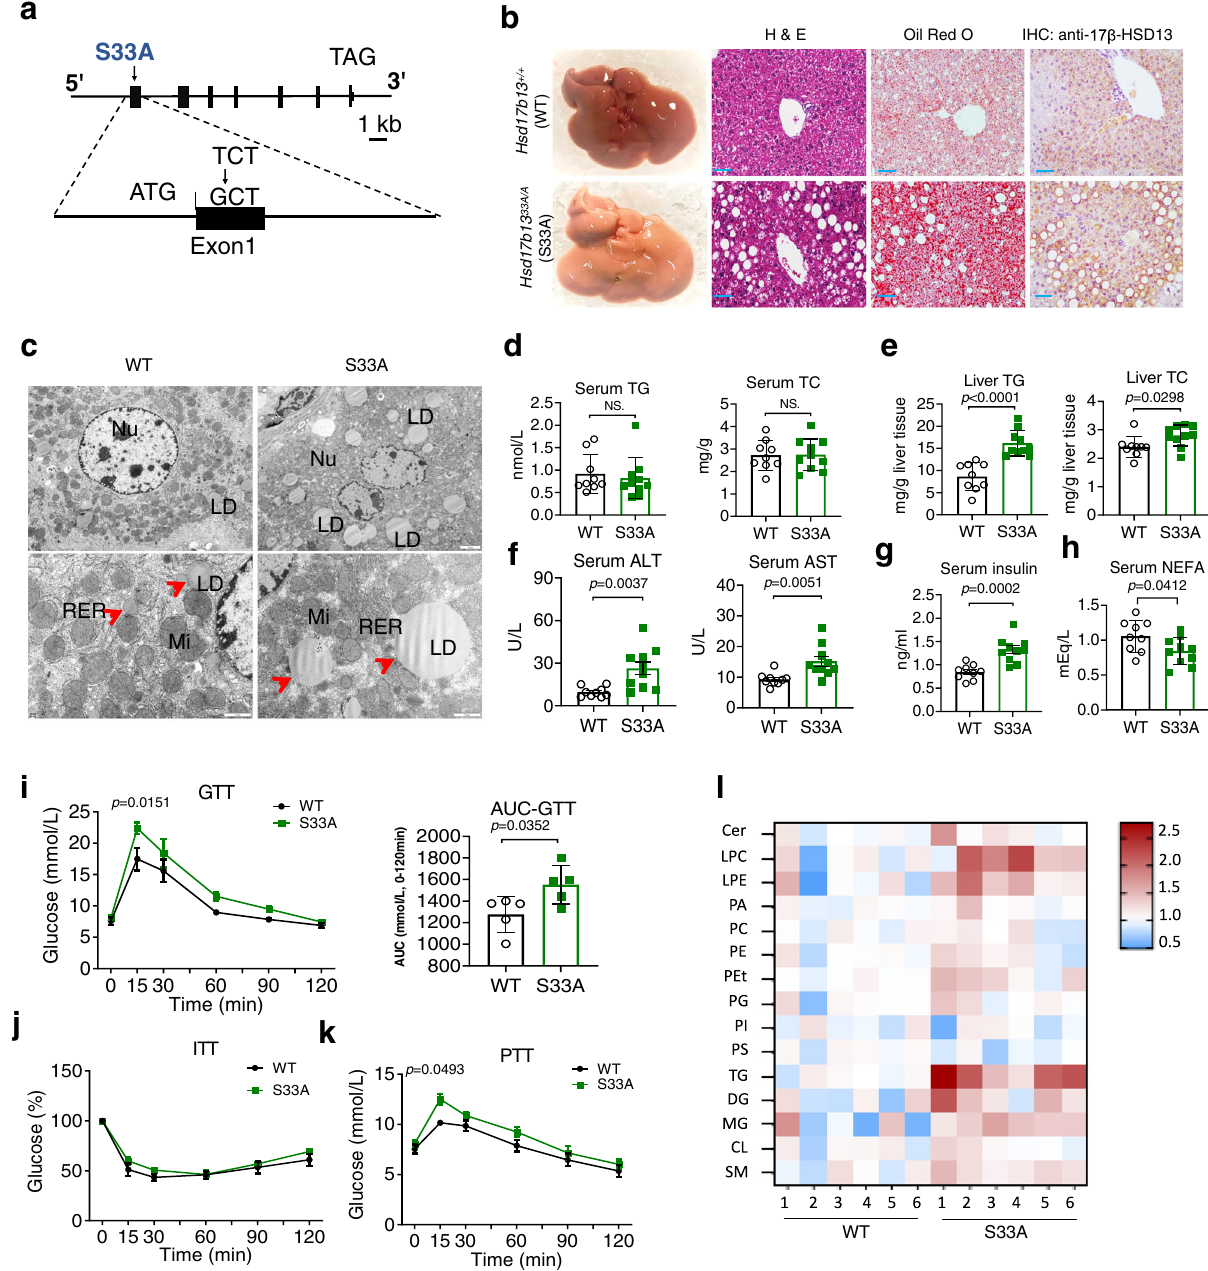
Fig. 3 | Targeted knock-in of the 17 β -HSD13 S33A mutation drives NAFLD pathogenesis. a Schematic representation of the gene targeting strategy of 17 β - HSD13 S33A. Homologous recombination was used to replace exon 1 with the correspondingmutantsequence,resultinginasubstitutionofalanineforserine33 in 17 β -HSD13. b Representative liver gross view, H&E staining, Oil red O staining, and immunohistochemistry (IHC) pictures in the Hsd17b13 33+/+ (WT) and Hsd17b13 33A/A (S33A)fedachowattheageof5months;Scalebar,100 μ m.WT: n =5; S33A: n =5 biologically independent animals. c Transmission electron microscopy (TEM)analysisoflipiddroplets(LDs)intheliversofWTandS33Amice.Nunucleus; mi mitochondria; RER Rough endoplasmic reticulum. Scale bar=2 μ m (upper panels); 1 μ m (lower panels); WT: n =3; S33A: n =3 biologically independent